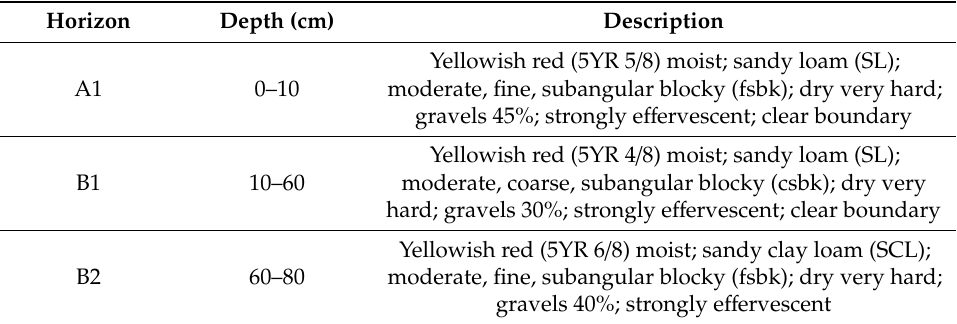
Table A16. Profile P8 horizons description.